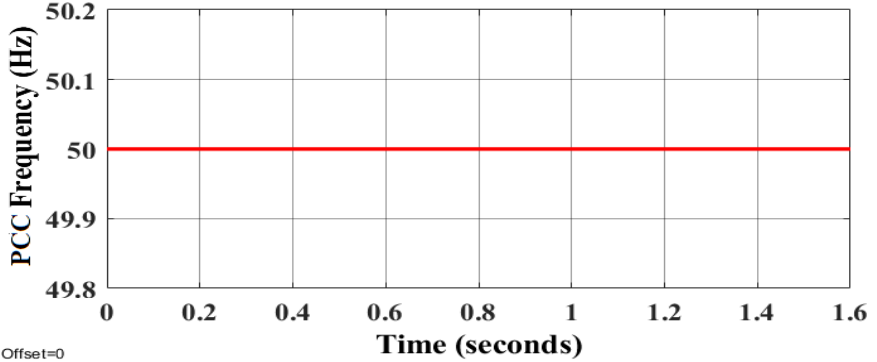
Figure 17. AC common bus frequency using the proposed technique under changing load conditions.